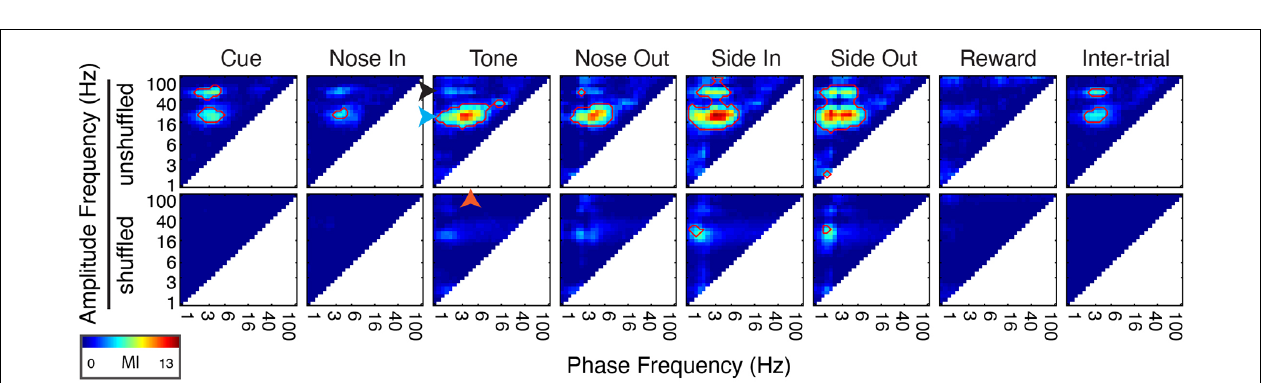
FIGURE 5 | Phase-amplitude coupling (PAC) is dynamically modulated by task events. (Top) Peri-event PAC as assessed by the mean modulation index (MI, see “Materials and Methods” section) for all 30 sessions ( n = 5 rats). Arrows indicate specific frequencies in the delta (2.5 Hz, orange arrowhead), beta (20 Hz, blue arrowhead), and low gamma (55 Hz, black arrowhead) bands. (Bottom) Same calculation using trial shuffled data. Red outlines highlight areas where PAC is significant ( p < 0.05, corrected for multiple comparisons).